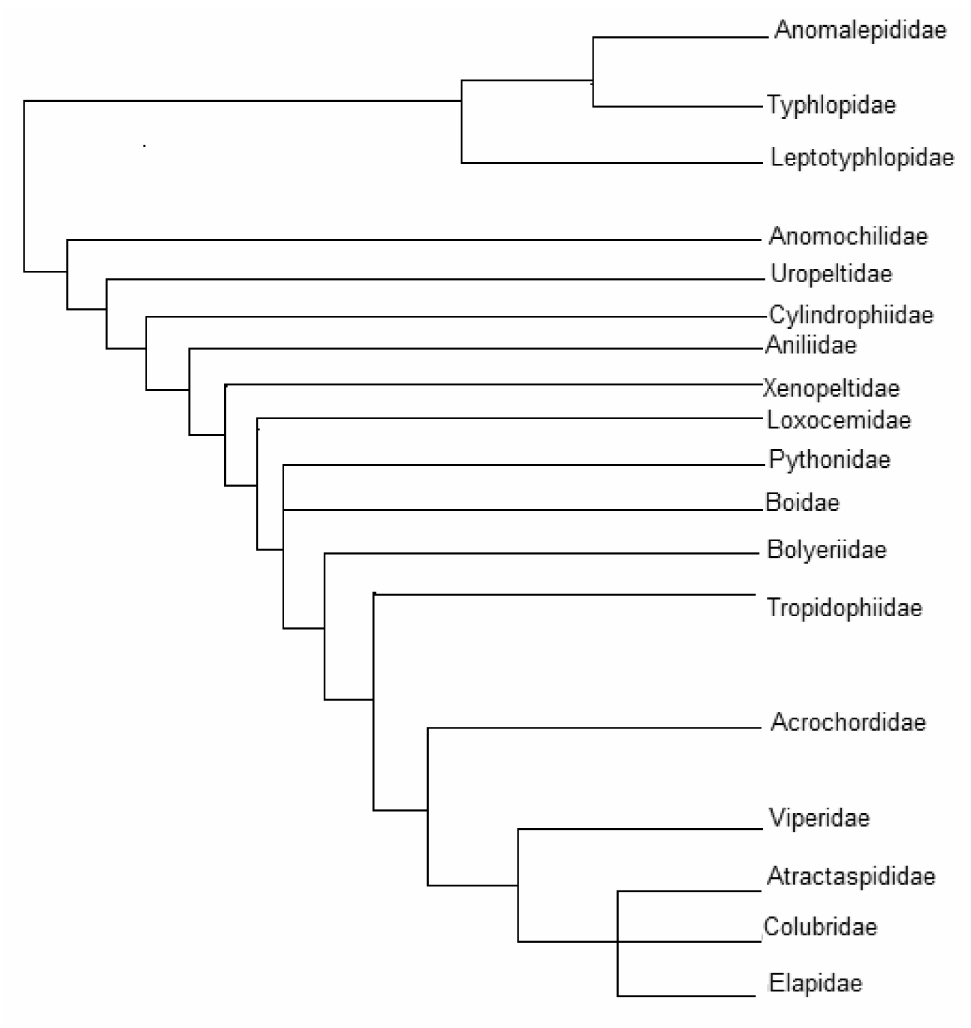
Fig. 3. Phylogenetic tree showing the relationships among the 18 families of snakes (re-drawn from Halliday and Adler 2002). Overall, primitive groups are upper-right of the graphic, and advanced groups are lower-right of the